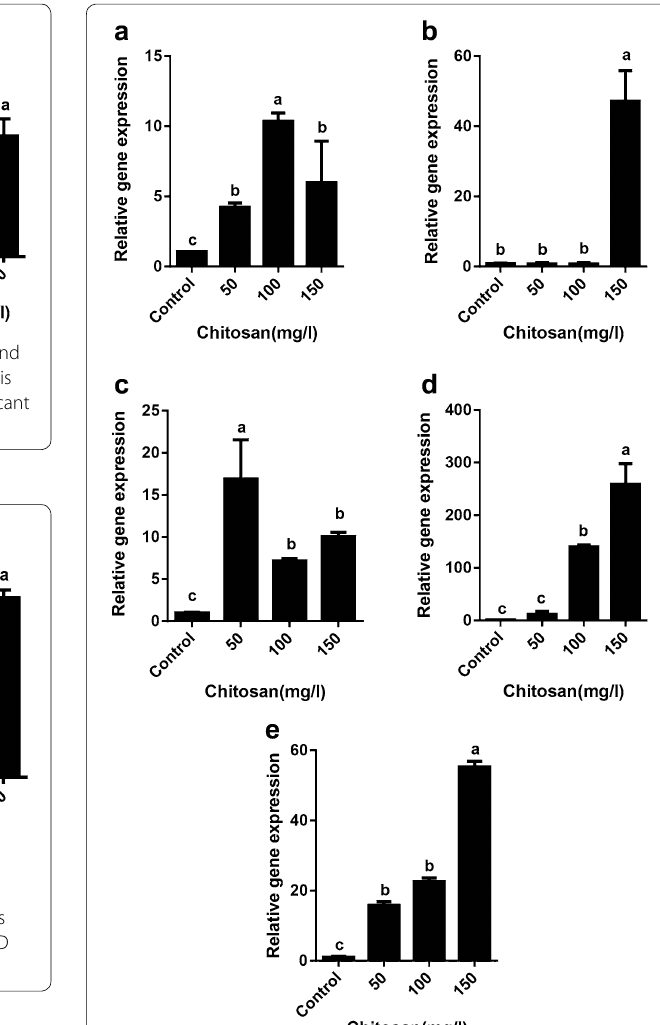
Fig. 6 Effect of chitosan levels on gene expression of TAT ( a ), PAL ( b ), RAS ( c ), RBOH ( d ) and OPR3 ( e ) of Melissa officinalis shoot cultures. Each value is expressed as mean standard deviation. Differences ± were significant at p < 0.05 level (one-way ANOVA followed by LSD